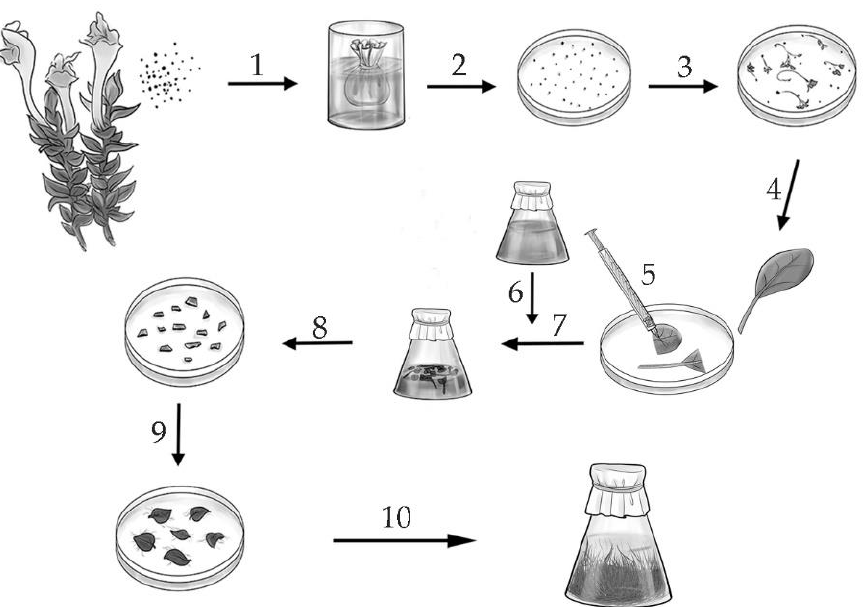
Figure 1. Scheme for obtaining the hairy roots of plants of the genus Scutellaria by transformation with Agrobacterium rhizogenes . 1—seeds, 2—seed sterilization, 3, 4—seed germination on a solid nutrient medium, 5—damaging explants with an insulin syringe, 6—preparation of a daily culture of